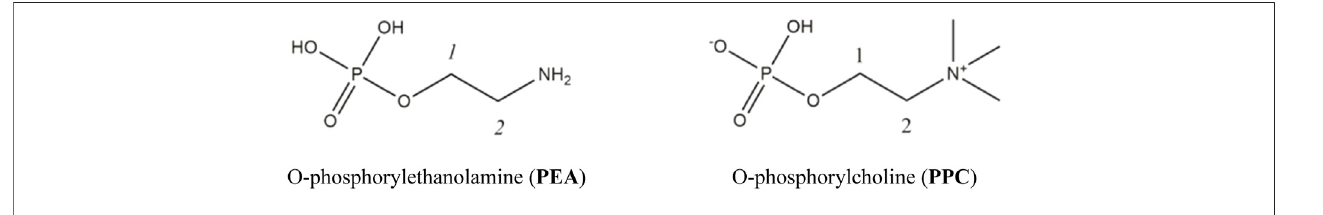
FIGURE 1 | Ligands under